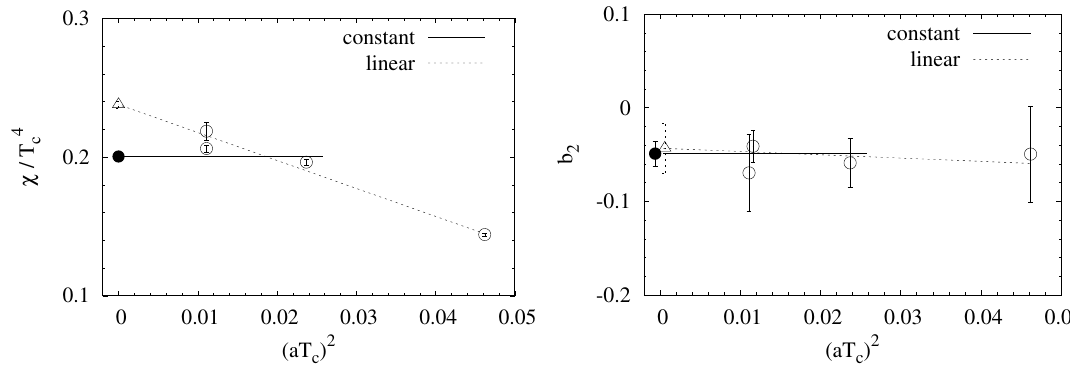
and b . The solid lines in both plots are the results from 2 c